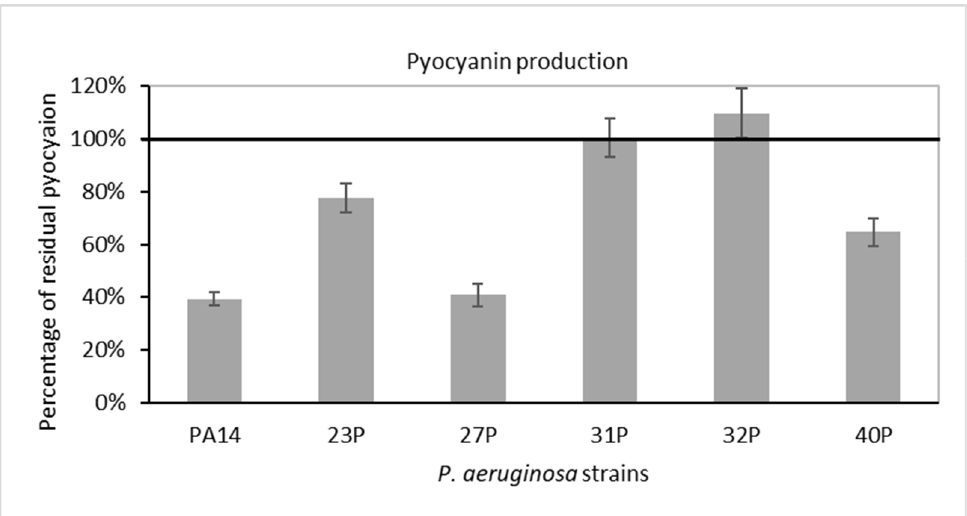
Figure 3. Effect of SN_TAE2020 on pyocyanin production after 48 h of incubation. Data are reported as a percentage of residual pyocyanin production after the SN_TAE2020 treatment in comparison with controls (bacteria grown in the presence of Gut diluted 1:5). Each data point is composed of 4 independent experiments, each performed in at least 3 replicates.